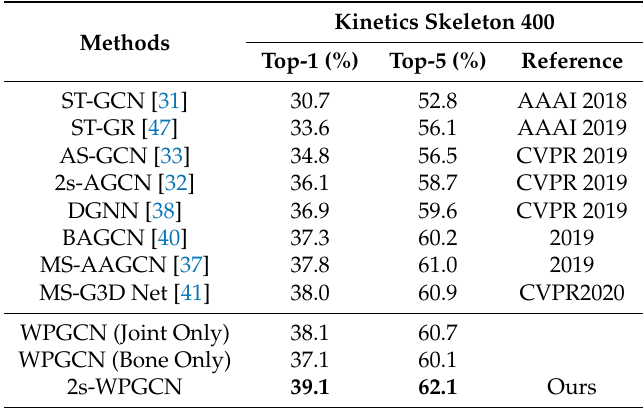
Table 7. Recognition accuracy comparison against state-of-the-art methods on the Kinetics Skeleton 400 dataset. The best results are shown in